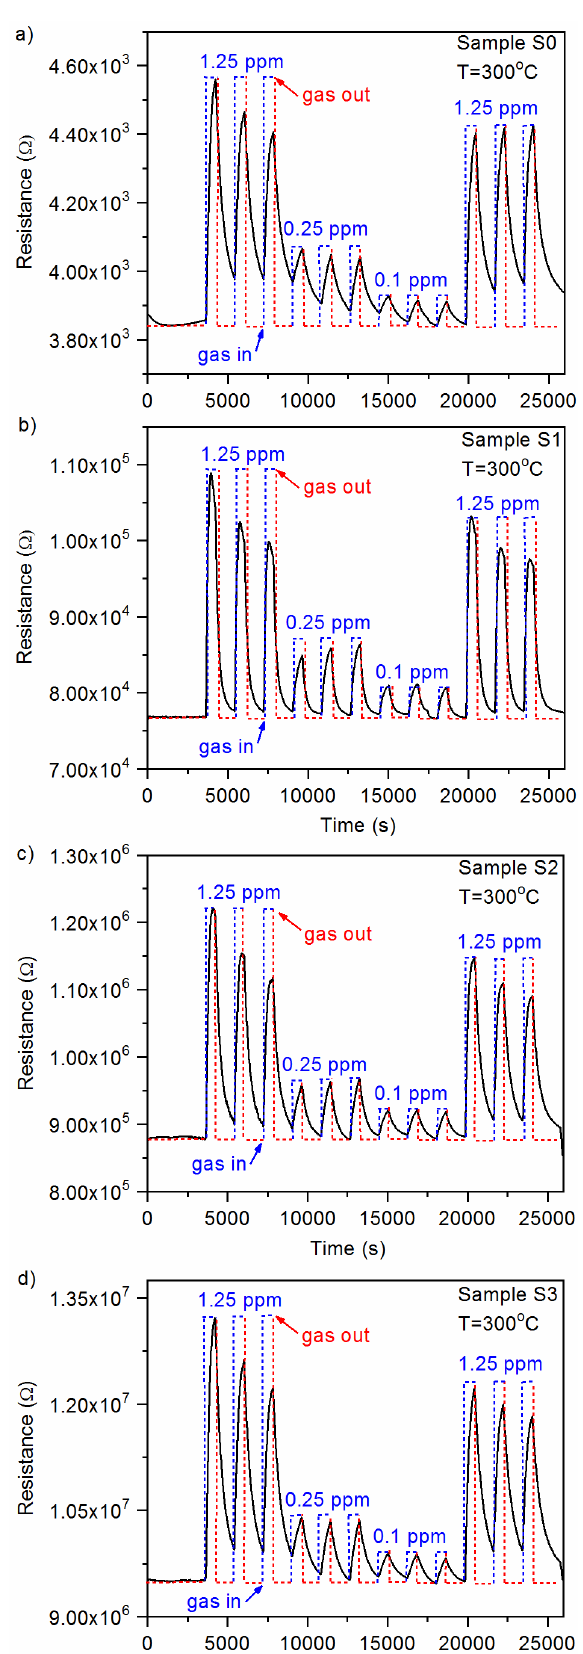
Figure 6. Sensor response as a function of acetone concentration at ( a ) 300 ◦ C and 50% RH for CuO (sample S0), ( b ) CuO:Ga films deposited with 4% at. (sample S1); ( c ) 8% at. (sample S2); ( d ) 16% at. (sample S3) of gallium